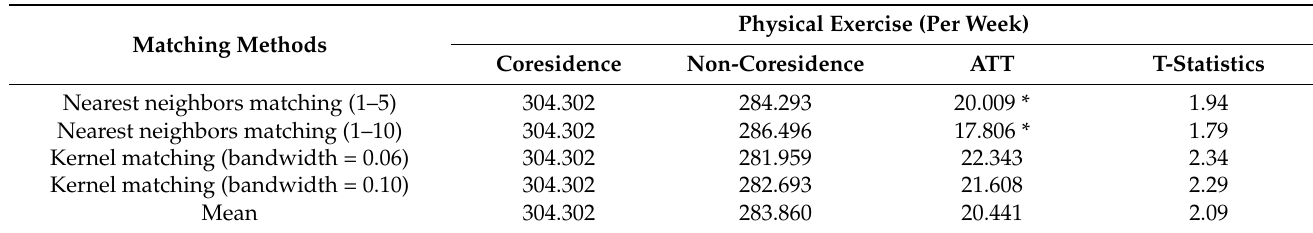
Table 8. Effect of grandparents’ coresidence on children’s and adolescents’ activity.